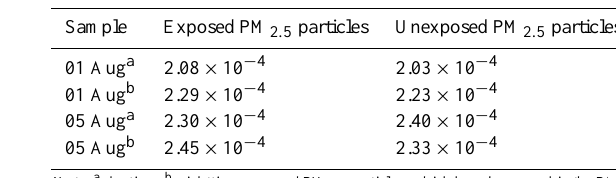
Table 1. Comparison of γ PAA on exposed and unexposed PM 2 . 5 filters